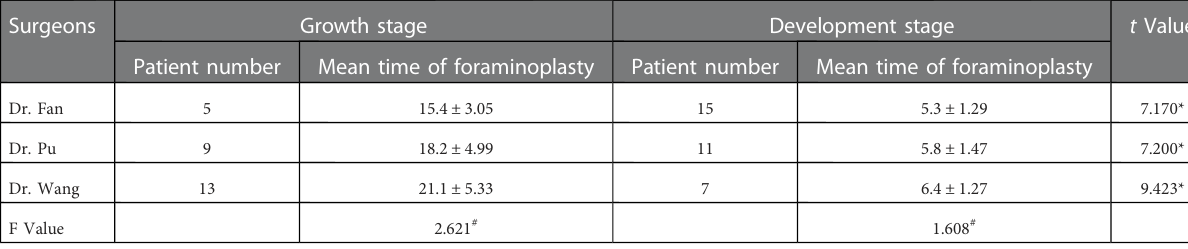
TABLE 2 Time of foraminoplasty by three surgeons during the different stages. Surgeons Growth